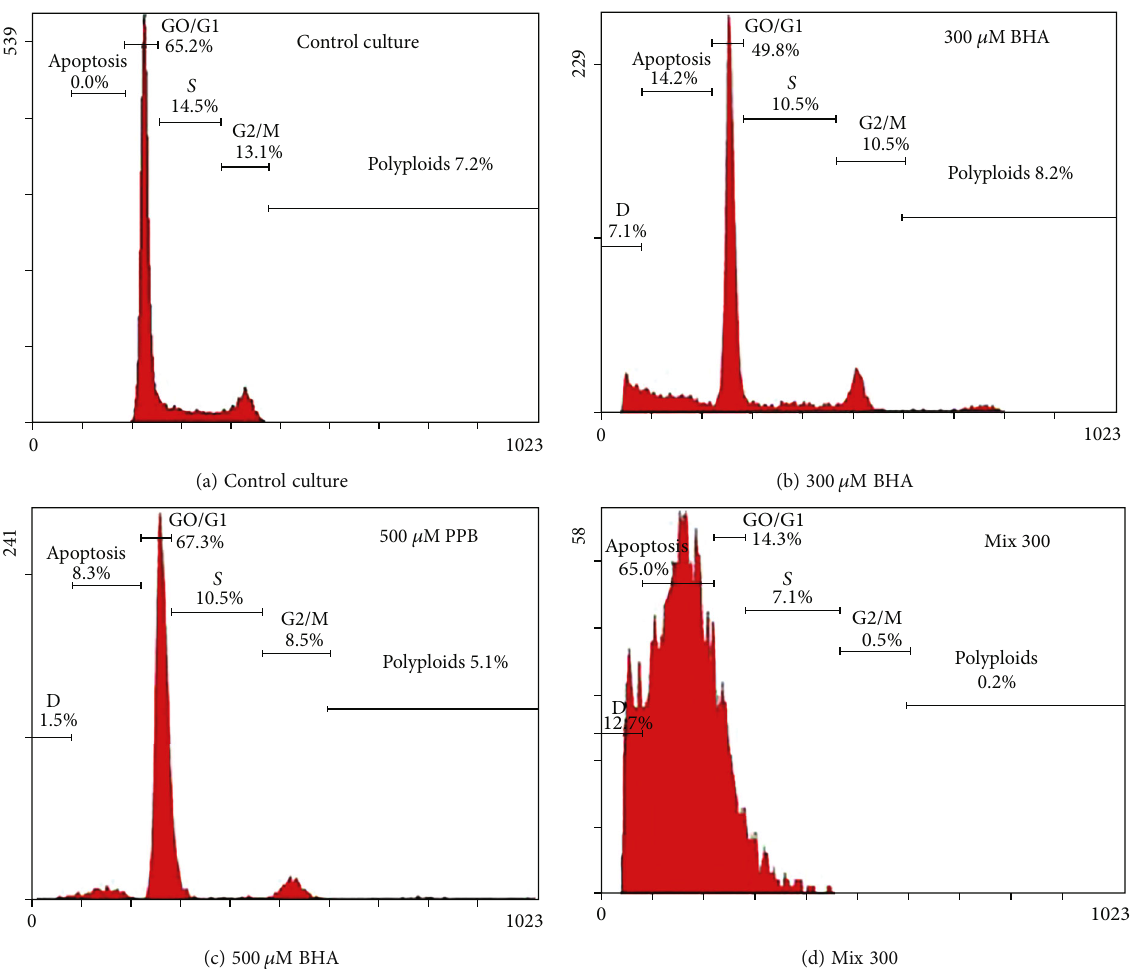
Figure 9: Representative histograms of cell frequencies in each cell cycle phase analysing DNA loading by fl ow cytometry after 48hours of continuous exposure to BHA and/or PPB ( n = 6 per